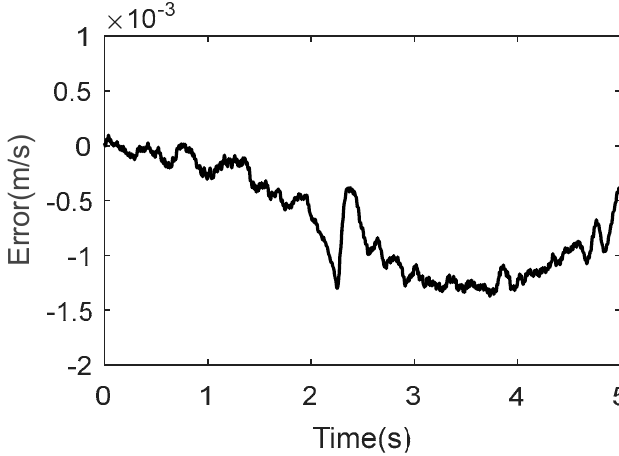
Figure 6. Tracking errors of ARC.